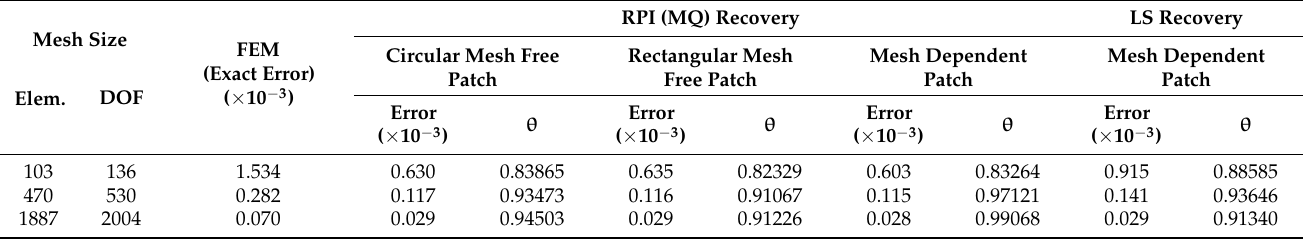
Table 7. Error convergence and global effectivity ( θ ) obtained for RPI (MQ) and least square based displacement recovery techniques (linear triangular, L 2